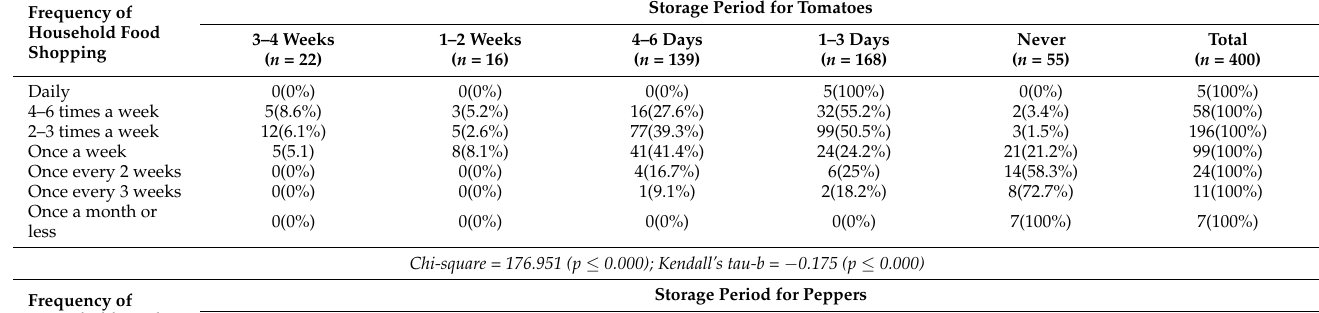
Table 4. Relationship between frequency of household food shopping and storage of tomato and